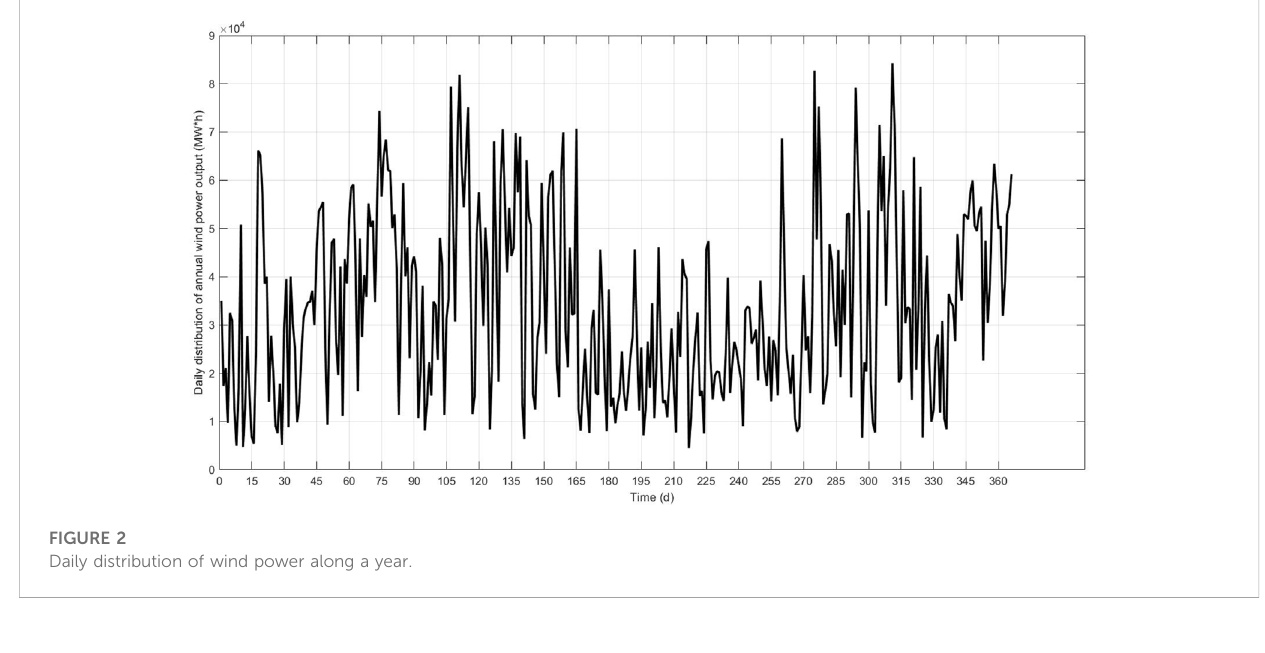
FIGURE 2 Daily distribution of wind power along a